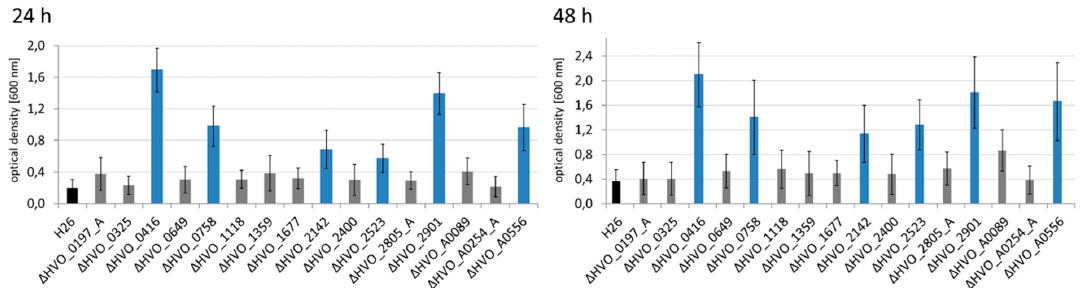
Figure 4. Comparison of the biofilm formation of the parent strain H26 (black) and its 16 deletion mutants after 24 h and 48 h incubation. The mutants with a gain of function phenotypes are shown in blue. Average values of three biological replicates and their standard deviations are shown.